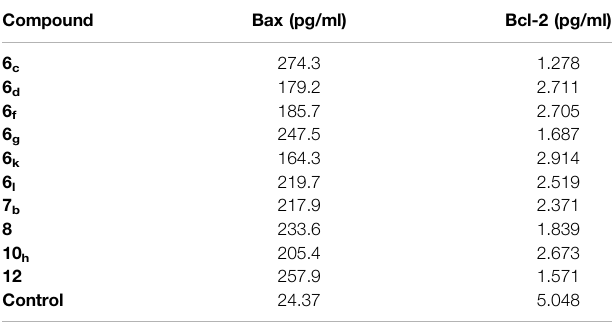
TABLE 4 | Effect of compounds 6 c , 6 d , 6 f , 6 g , 6 k , 6 l , 7 b , 8 , 10 h , and 12 on the expression levels of Bcl-2 and Bax in HepG-2 cells. Compound Bax (pg/ml) Bcl-2